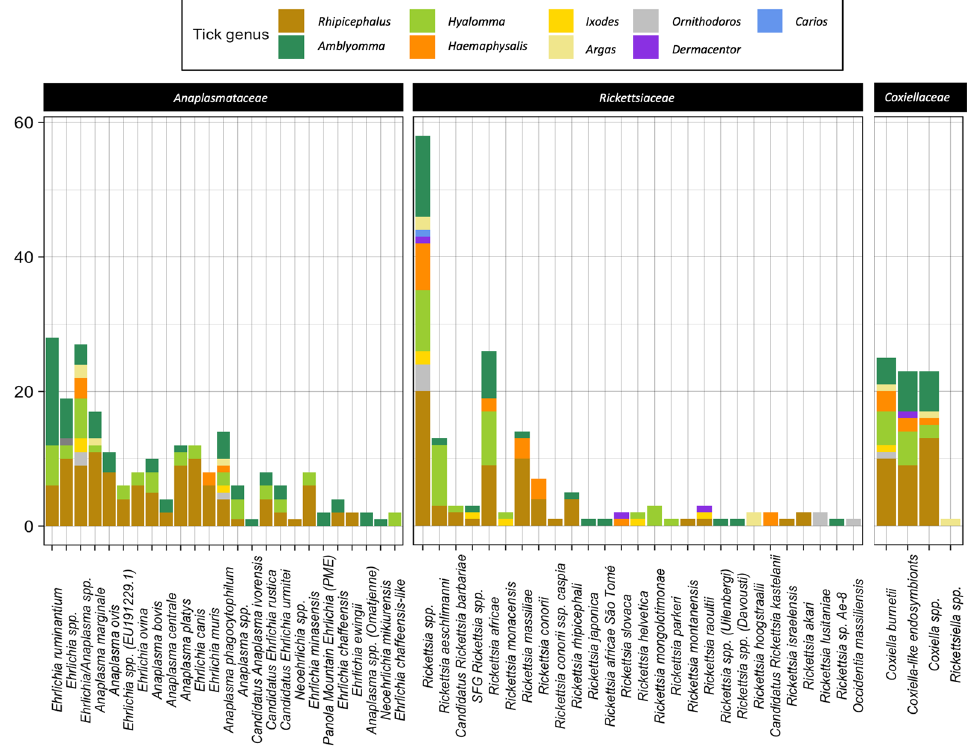
Figure 5. Number of tick species within each genus infected with different pathogen species. A total of 25 Rickettsia species were identified in African ticks. The most reported Rickettsia species was R. africae (38 studies), followed by R. aeschlimanni (24 studies), R. massiliae (19 studies) and R. conorii (12 studies) (Table 1). Rickettsia africae was reported in 26 African tick species (Figure 5), mainly Amblyomma variegatum (18 studies), across 17 African countries, i.e., in 71% of the total number of countries where R. africae has been reported (Figure 6). The main African countries that detected infection with R. africae in ticks were Kenya (nine studies), South Africa (four studies) and Ethiopia (four studies). Rickettsia aeschlimanni was detected in 13 tick species (Figure 5), mostly Hyalomma (69% of total tick species) and mainly from Hyalomma rufipes (12 studies), Hyalomma trun- catum (six studies), Hyalomma impeltatum (six studies) and Hyalomma marginatum (four studies). Rickettsia massiliae and R. conorii were detected almost exclusively in Rhipicephalus spp. and Haemaphysalis spp. (nine and six tick species, respectively), and mainly in Rhip- icephalus sanguineus (nine and six studies, respectively; Figure 5). The northwestern part of the African continent has reported the highest prevalence of these Rickettsia species, although they have also been reported in central–southern African countries (Figure 6).